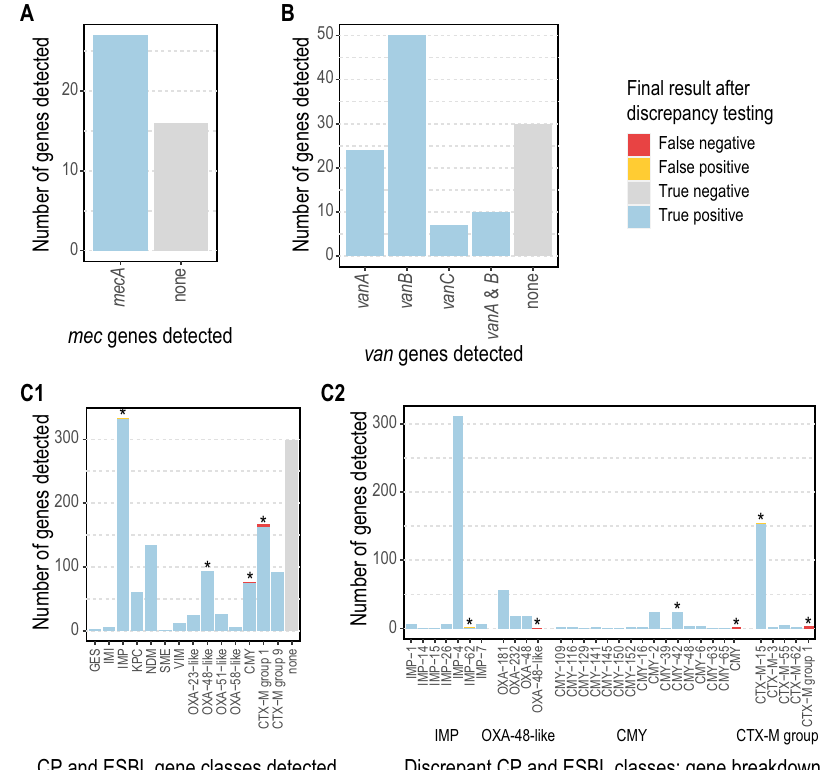
Fig. 4 | Performance of abritAMR pipeline to detect AMR mechanisms com- pared to PCR. Each panel details the identi fi cation of AMR mechanisms by abri- tAMR comparedtothe ‘ goldstandard ’ multiplexPCRassaysusedinourlaboratory. True positive, detected by both PCR and abritAMR ; true negative, not detected by eitherPCRor abritAMR ;falsepositive,detectedby abritAMR butnotmultiplexPCR, and withintheknownrangeofthePCRassay;falsenegative,detectedbymultiplex PCR but not by abritAMR . Panel A , mec genes compared to multiplex PCR ( mecA/ mecC , no mecC detected by either method). Panel B , van genes compared to